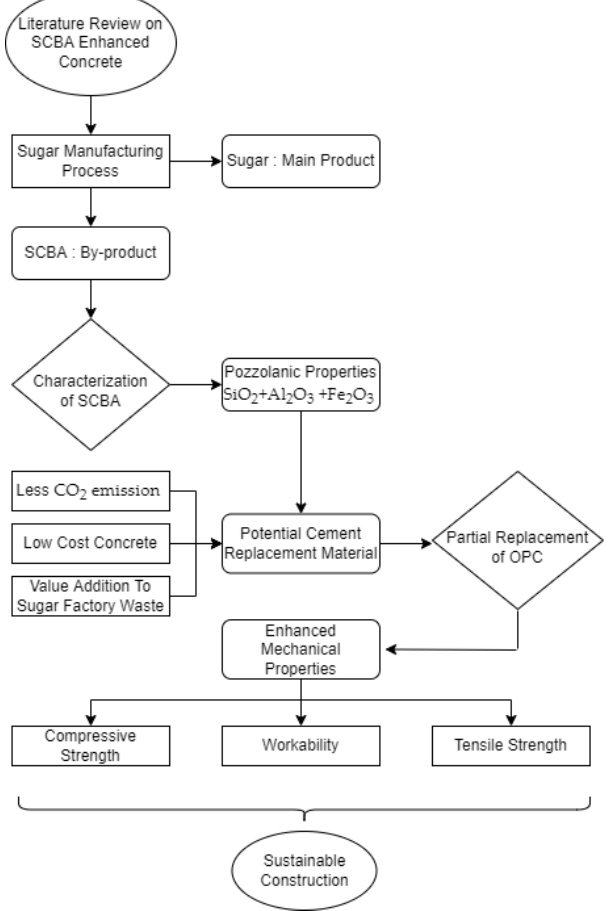
Figure 1. Scope of the review article (Sugarcane Bagasse Ash — SCBA).